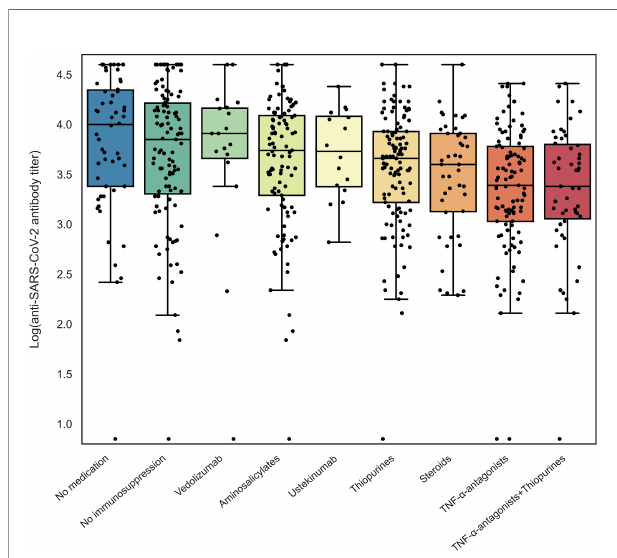
FIGURE 2 | Log-transformed anti-SARS-CoV-2 antibody titers for patients with IBD according to different types of medications used. Patients using a speci fi c type of medication were compared to non-users for log-transformed anti-SARS-CoV-2 antibody titers using independent sample t-tests (see Table 2